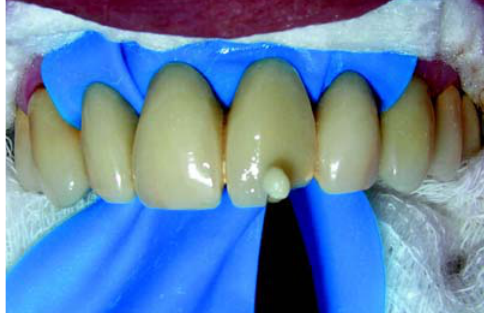
FIGURE 6- Composite resin insertion over the fractured angle